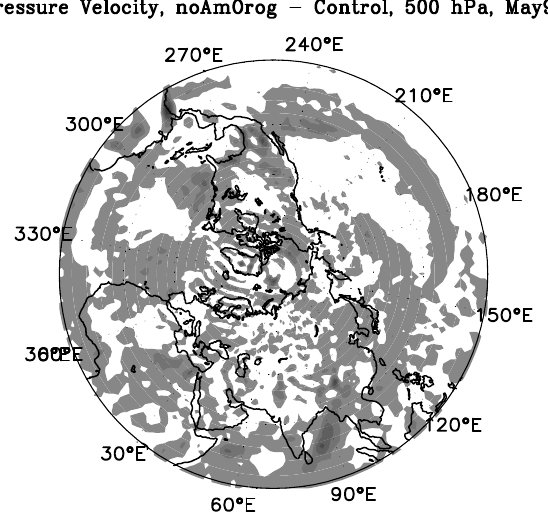
Fig. 19. Difference in 500hPa vertical pressure velocities between the control and noAmOrog simulations. Shaded regions show rel- ative positive velocity for the noAmOrog simulation and therefore more downward motion at the mid-troposphere.